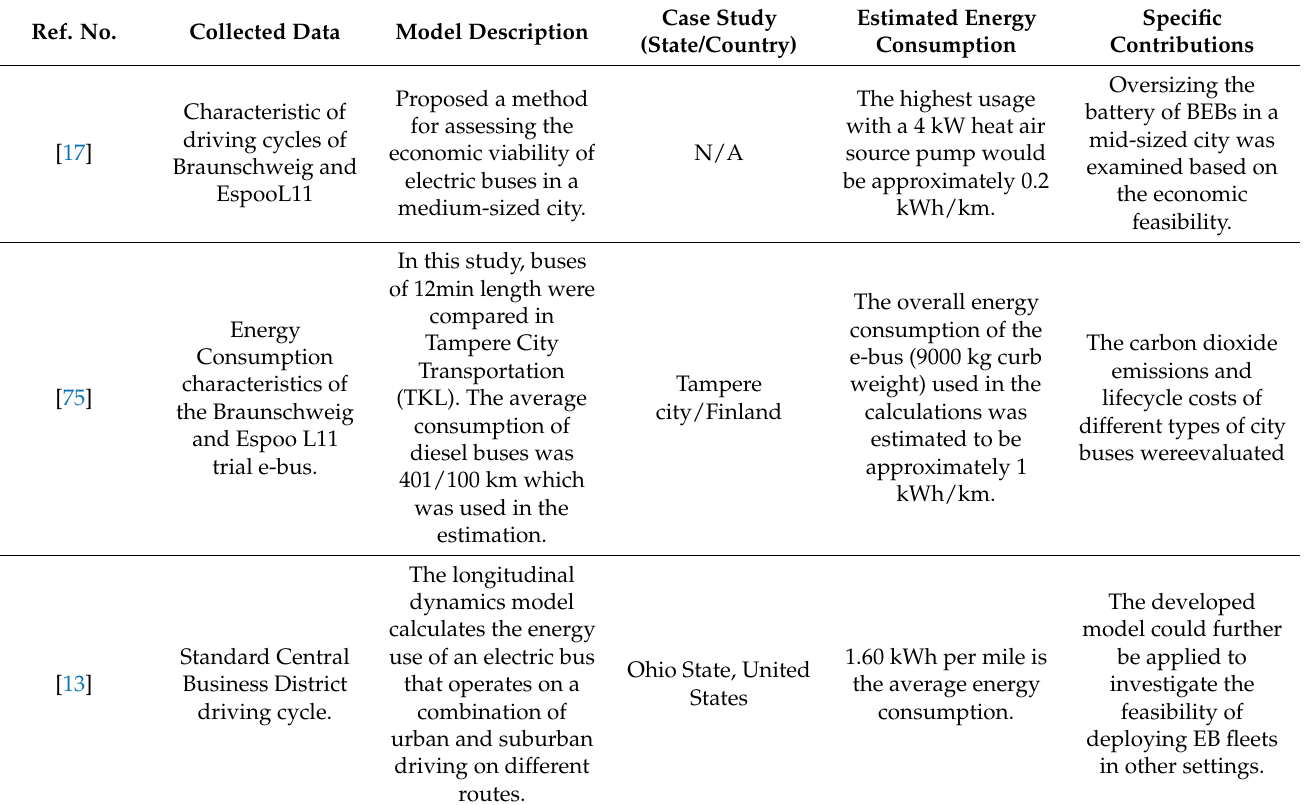
Table 3. Energy consumption models according to driving-cycle